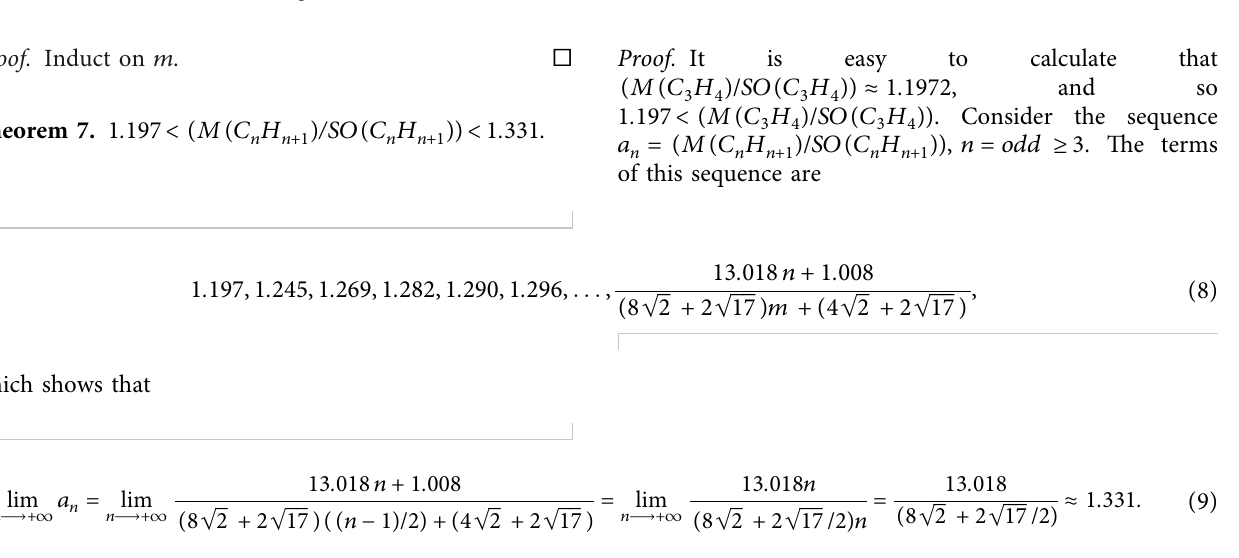
Figure 6: Diagram of Sombor index and molecular mass for some annulenes ( n � even ≥